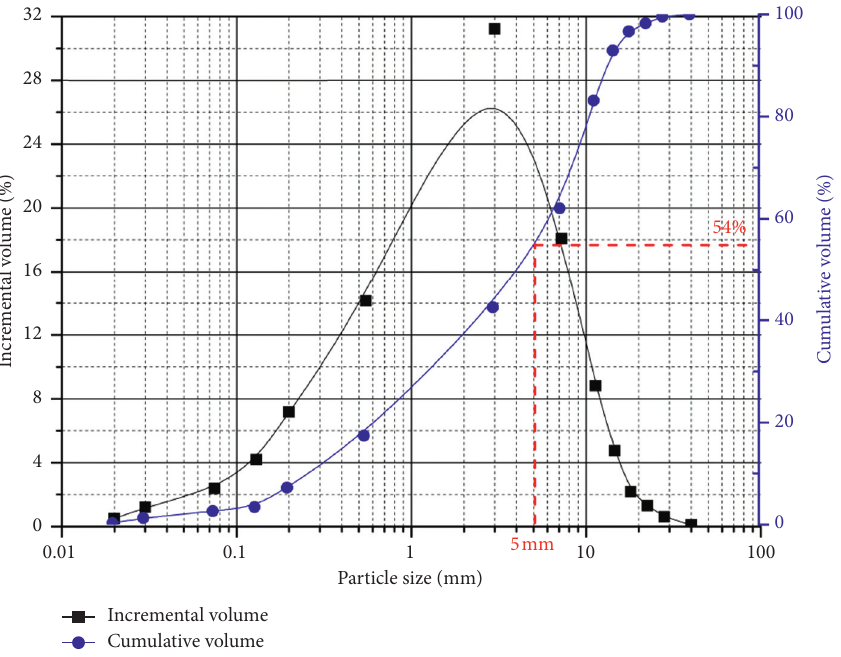
Figure 3: Particle size distribution of coal gangue. Table 1: Chemical composition of coal gangue and fly ash.